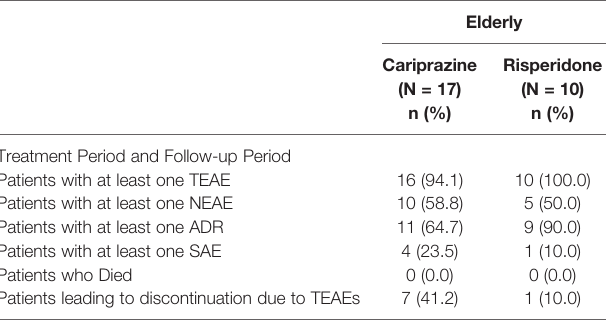
TABLE 6 | Overall summary of treatment-emergent adverse events (Safety Analysis Population).